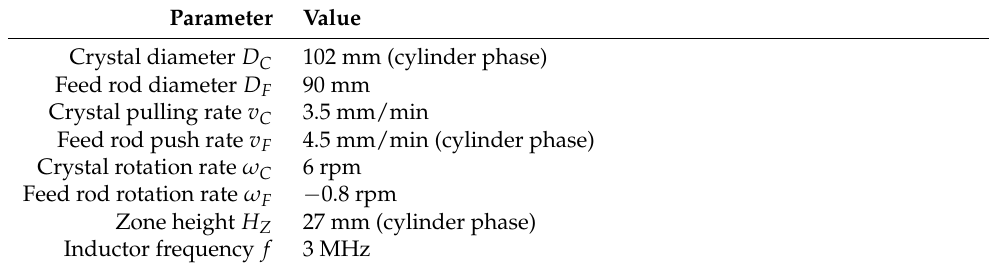
Table 1. Parameters of the